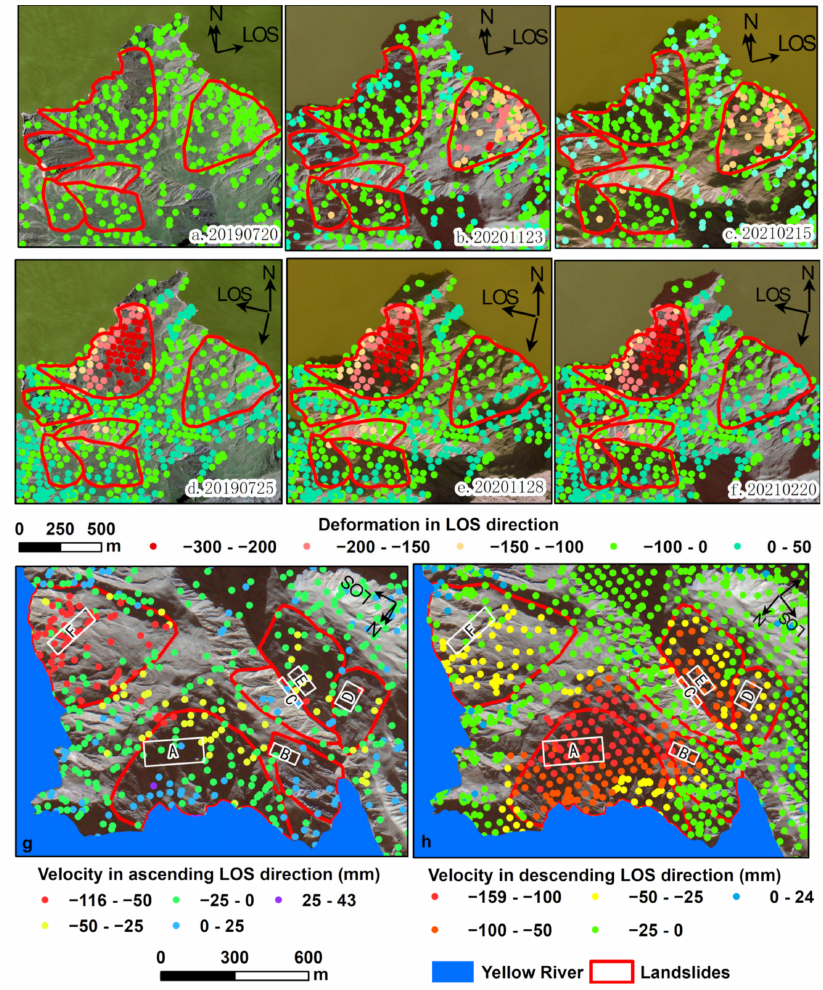
Figure 9. Interferometric point target analysis (IPTA) results for the Lijia Gorge landslide group from ascending and descending orbits. ( a ) Deformation in the ascending line-of-sight (LOS) direction on 20 July 2019. ( b ) Deformation in the ascending LOS direction on 23 November 2020. ( c ) Deformation in the ascending LOS direction on 15 February 2021. ( d ) Deformation in the descending LOS direction on 25 July 2019. ( e ) Deformation in the descending LOS direction on 28 November 2020. ( f ) Deformation in the descending LOS direction on 20 February 2021. ( g ) Deformation velocity in the ascending LOS direction. ( h ) Deformation velocity in the descending LOS